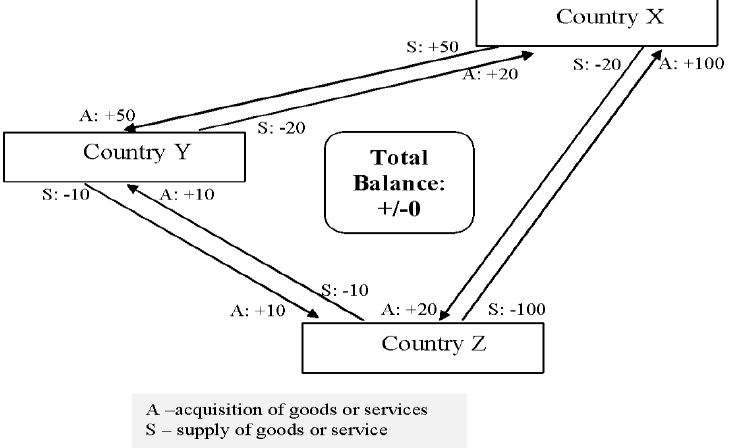
Fig. 1. Clearing system (developed by the